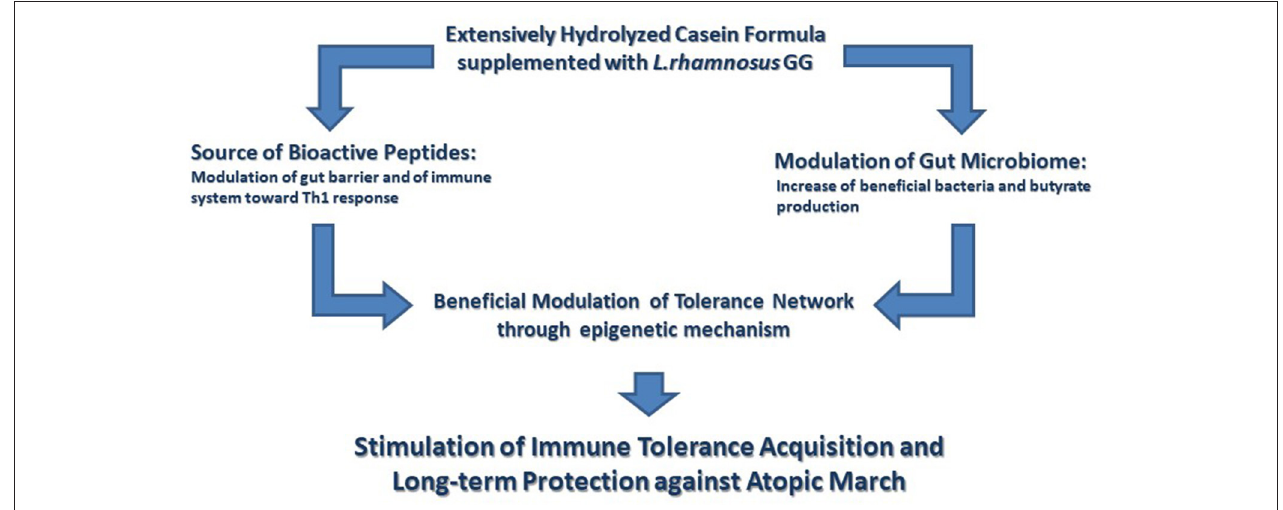
FIGURE 1 | The immunomodulatory effects elicited by the extensively hydrolyzed casein formula supplemented with the probiotic Lactobacillus rhamnosus GG. Extensively hydrolyzed casein formula supplemented with the probiotic Lactobacillus rhamnosus GG (EHCF + LGG) activates several tolerogenic mechanisms. These tolerogenic mechanisms are activated by the synergist action of immunomodulatory peptides, deriving from casein hydrolysis, and by the beneficial action of LGG on gut microbiome structure and function leading to an increased production of butyrate. Many of these effects involve an epigenetic regulation of gene expression with a central role in the maintenance of immune homeostasis. Altogether these immunomodulatory effects are able to facilitate the development of immune tolerance and to reduce the occurrence of atopic march.